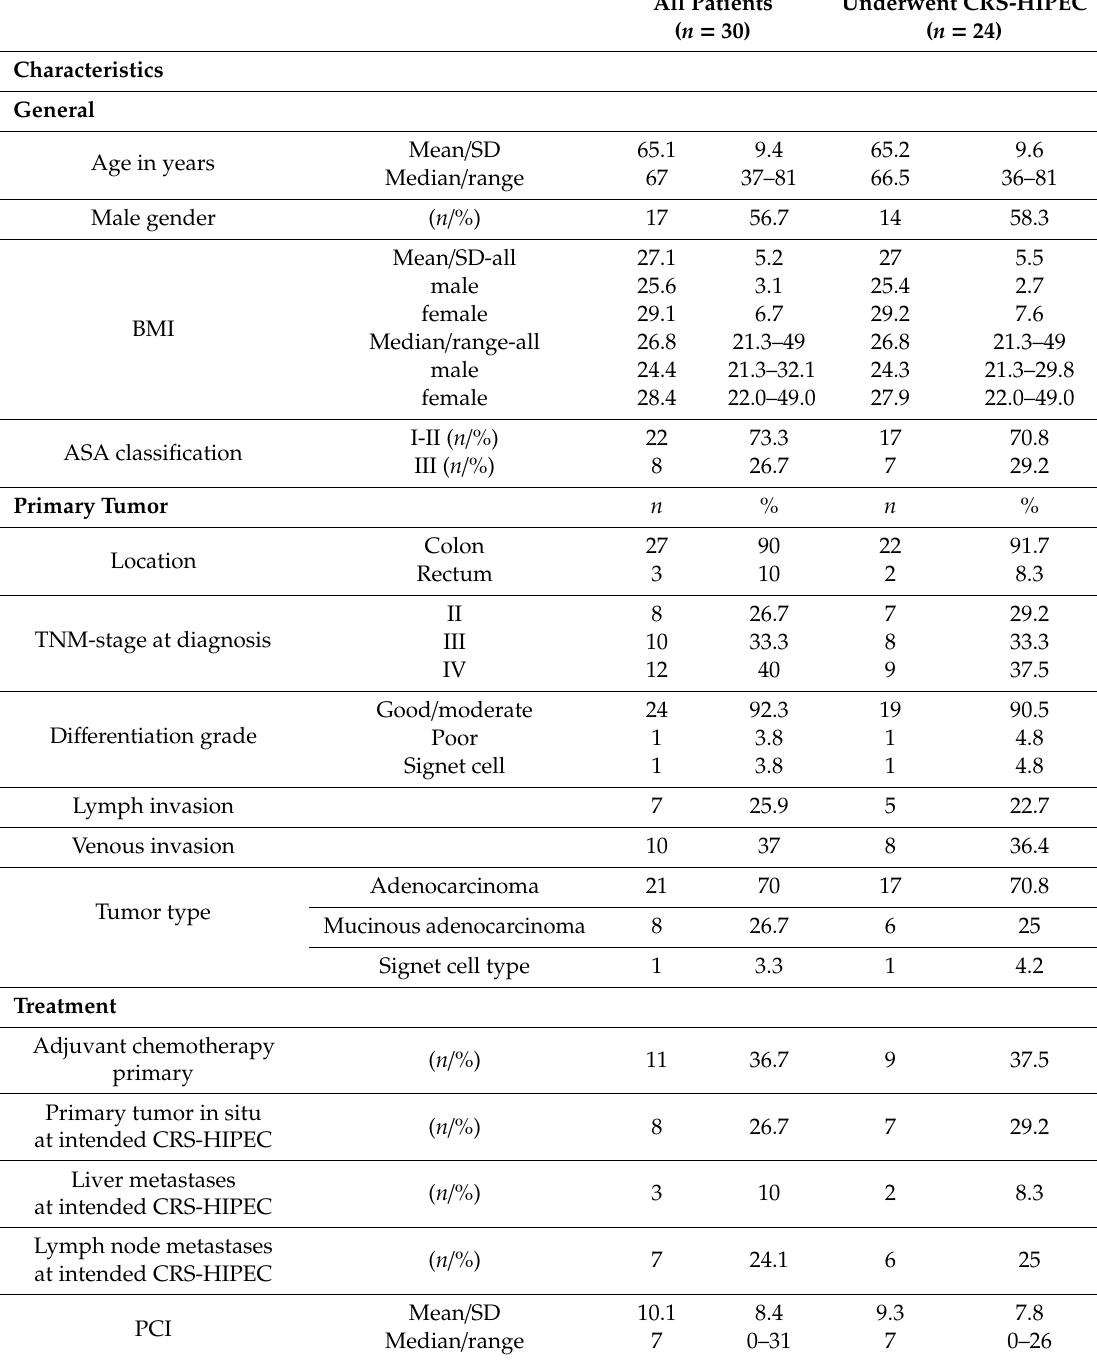
All Patients Underwent CRS-HIPEC ( n = 30) ( n =